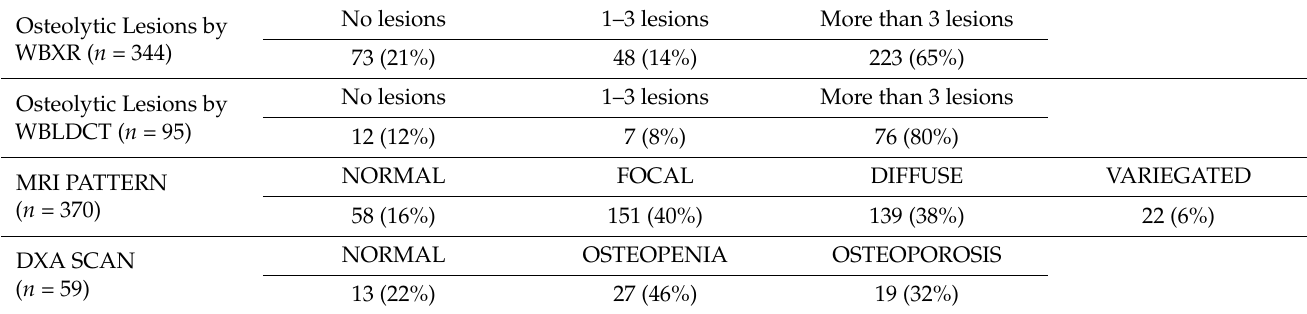
Table 2. Description of bone involvement at MM